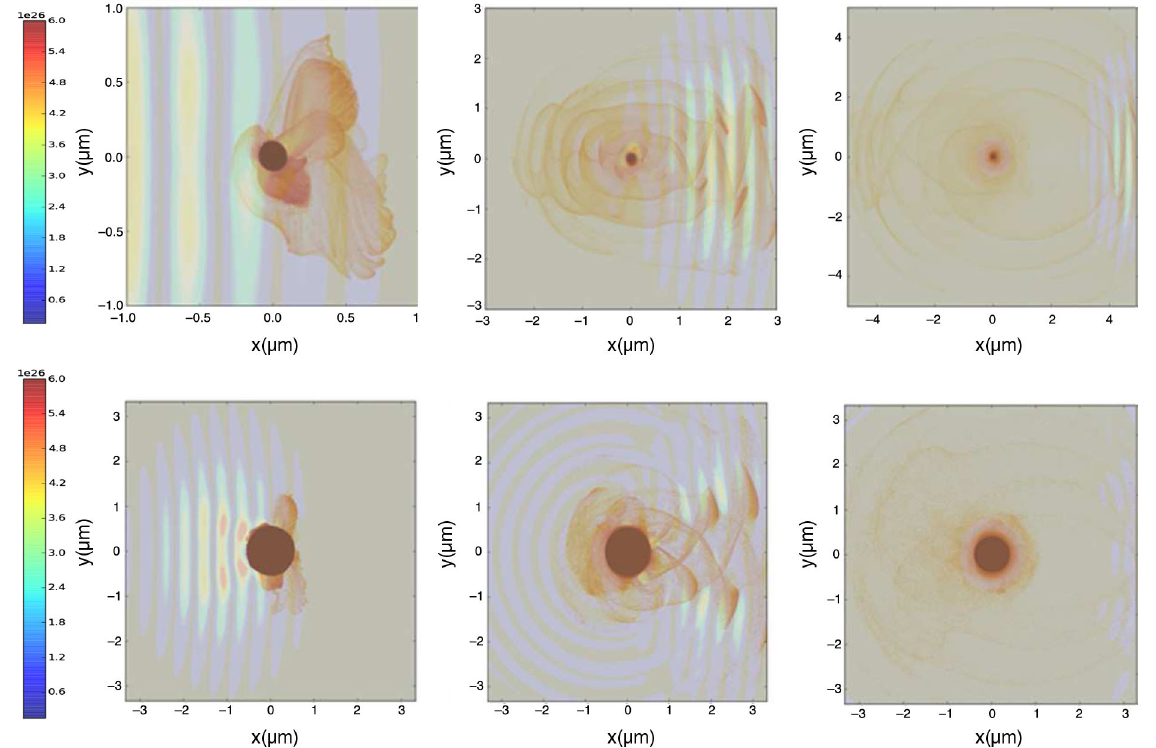
FIG. 7. Electric field energy density (in legend), superposed with the logarithmic plot of number electron density (in units of critical density 1 . 8 × 10 27 m − 3 ) for a droplet with radius 100 nm (above) and 1 micron (below) respectively hit by a laser pulse of intensity I ¼ 10 20 W = cm 2 at times ≈ 3 fs (a), 8 fs (b), 16 fs (c). Angles are measured considering the center of the most dense region of the bunch. In the logarithmic density scale, the maximum value corresponds to the critical density (see Fig.